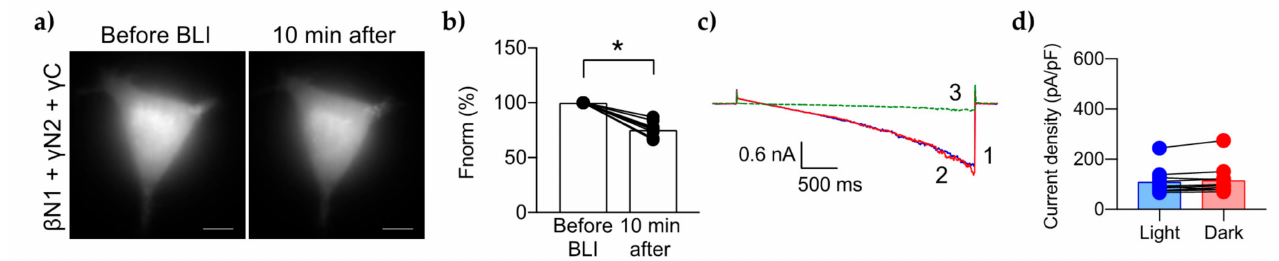
Figure 6. Effects of PIP2 depletion on the triple mutant. Representative micrographs showing the CoroNa Green fluorescence levels in HEK 293 cells transfected with triple mutant ENaC containing alanine substitutions to the β N1, γ N2, and γ C sites ( a ). Summary graph ( b ) of changes in the mean [Na + ] i as determined by CoroNa Green fluorescence levels. Representative current traces of the triple mutant ( c ) under BLI (1, blue trace), then dark (2, red trace), then 10 µ M amiloride (3, green trace). Summary graph of the mean current density for the triple mutant ( d ) at − 100 mV under low PIP2 levels (“Light”, blue bar and blue circles) vs. maximum PIP2 levels (“Dark”, red bar and red circles). *, p < 0.0001 determined by paired t